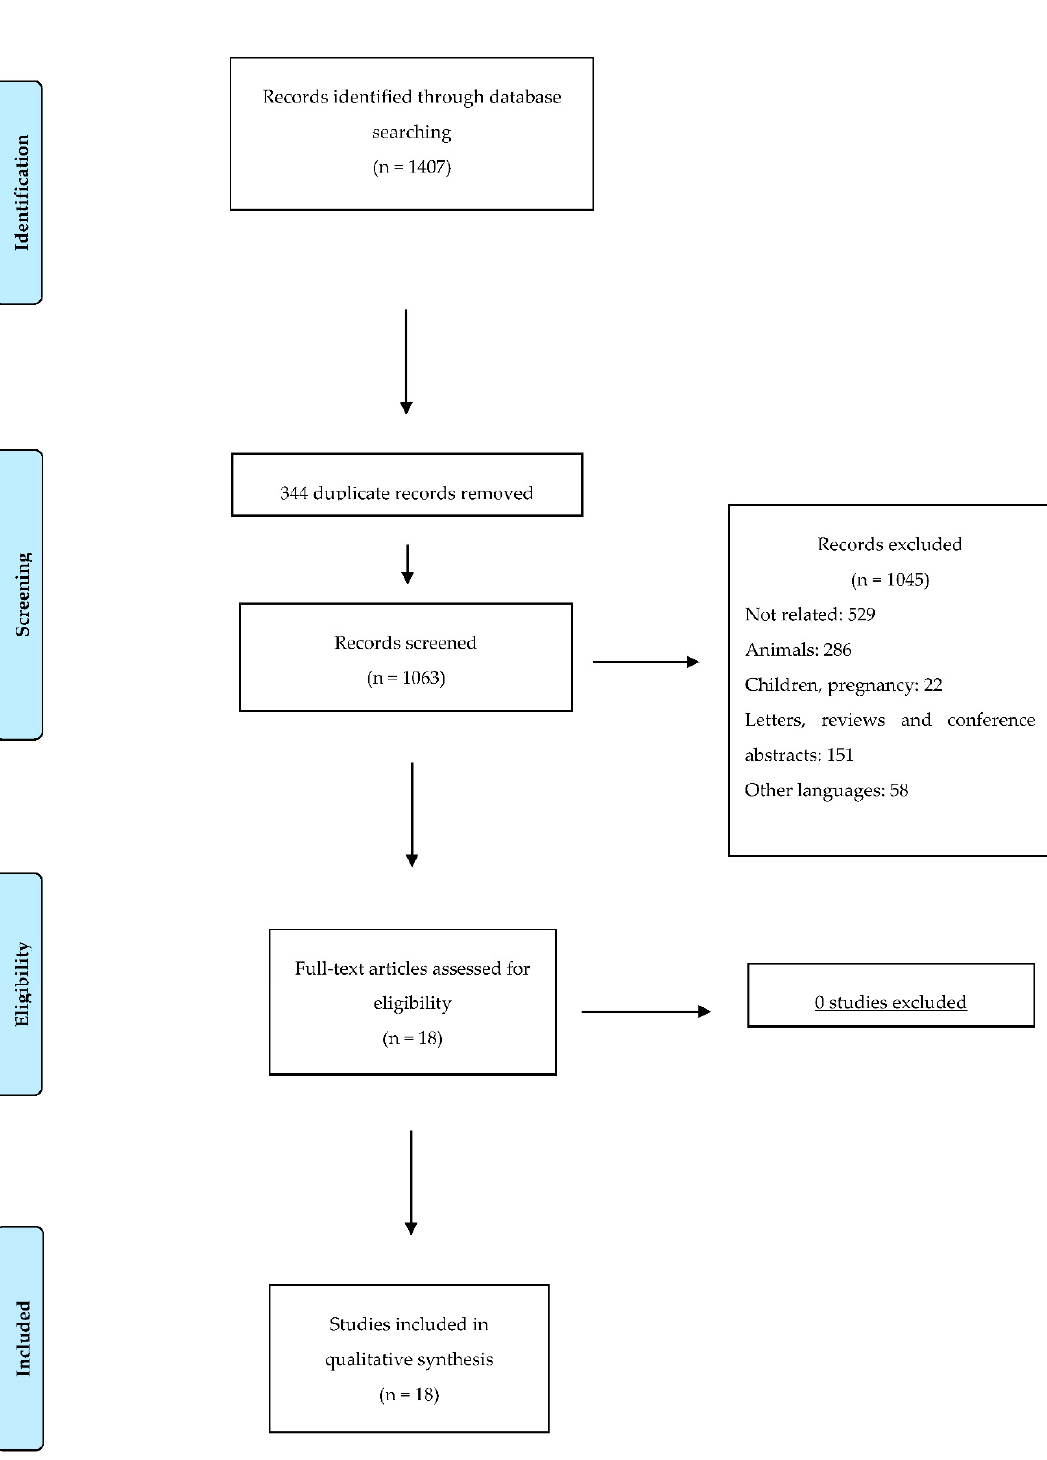
Figure 1. Flow diagram illustrating the search strategy used according to PRISMA (Preferred Reporting Items for Systematic reviews and Meta-Analyses)